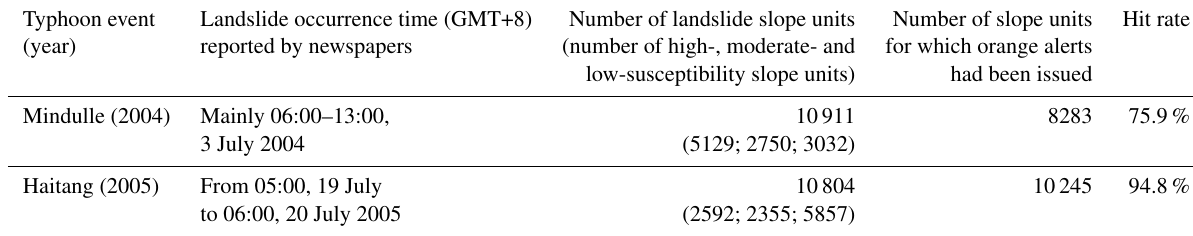
Table 10. Validation of warnings issued for slope units and the hit rate during Typhoons Mindulle and Haitang. Typhoon event Landslide occurrence time (GMT+8) Number of landslide slope units Number of slope units reported by newspapers (number of high-, moderate-